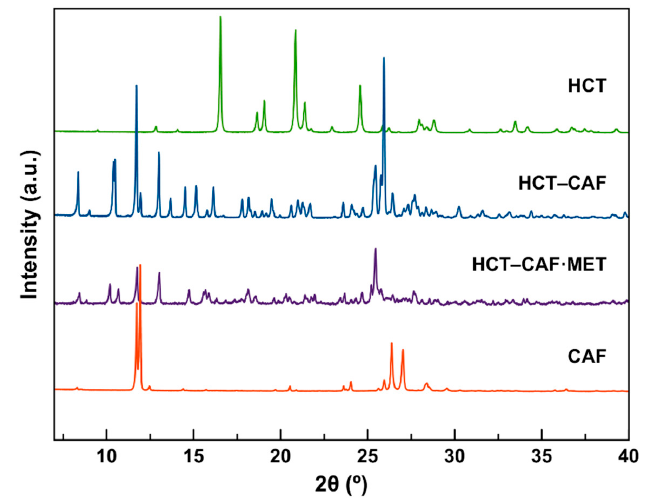
Figure 2. PXRD patterns of the new phases HCT–CAF and HCT–CAF · MET obtained by liquid- assisted grinding (LAG) with acetone (ACE) and methanol (MET) solvents respectively, and the corresponding reactants.